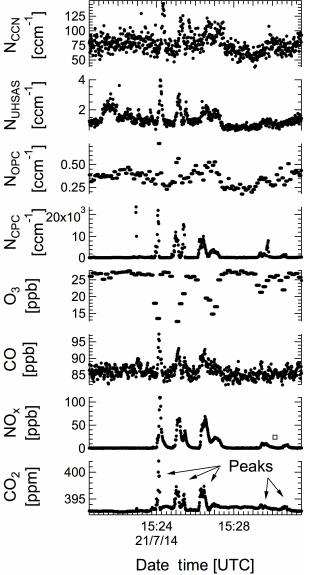
Figure 8. An example time series plot for identified pollution peaks in plume 3; sampling time for all instruments is 1s except for O 3 (10s) and OPC